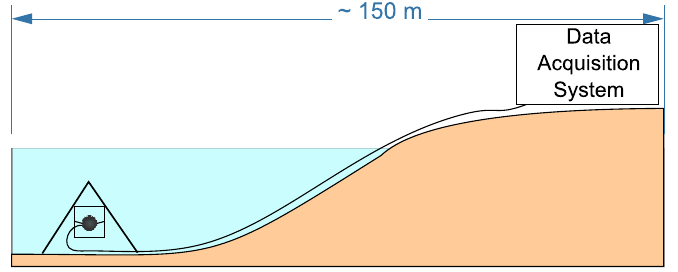
Figure 3. Scheme of the combined receiver setup at the bottom of Mikizha